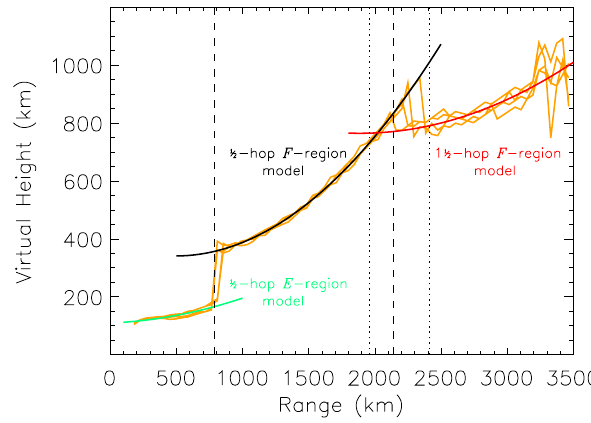
Fig. 11. Peak virtual height variations determined for four different beams. The black, blue, green, and yellow curves show the varia- tions for beams 3, 6, 9, and 12, respectively.